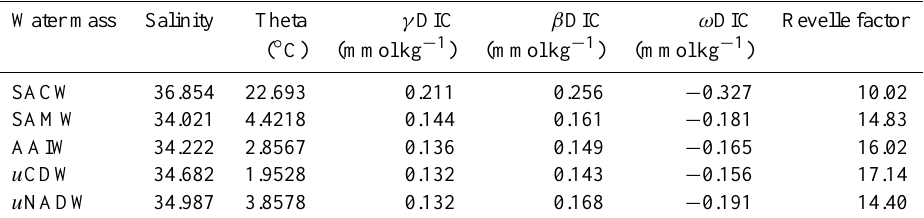
Table 3. The average water mass values of salinity and potential temperature, with accompanying average buffering capacity values ( γ DIC, β DIC, ω DIC and Revelle factor) calculated using the GEOTRACES-NL (2010/2011) data set. Water masses are determined using the same criteria as given in Table 2.